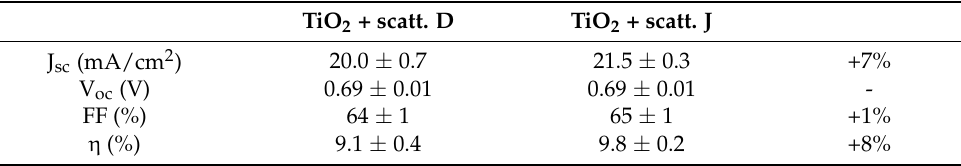
Figure 2. ( A ) SEM image of the sub-micrometric particle sizes (250, 300 and 500 nm) used for scattering layer. ( B ) SEM image of NPs. Table 1. Electrical parameter comparison between DSSC devices made with scattering D (Dyesol) and scattering J (homemade) . Relative increment is calculated as an